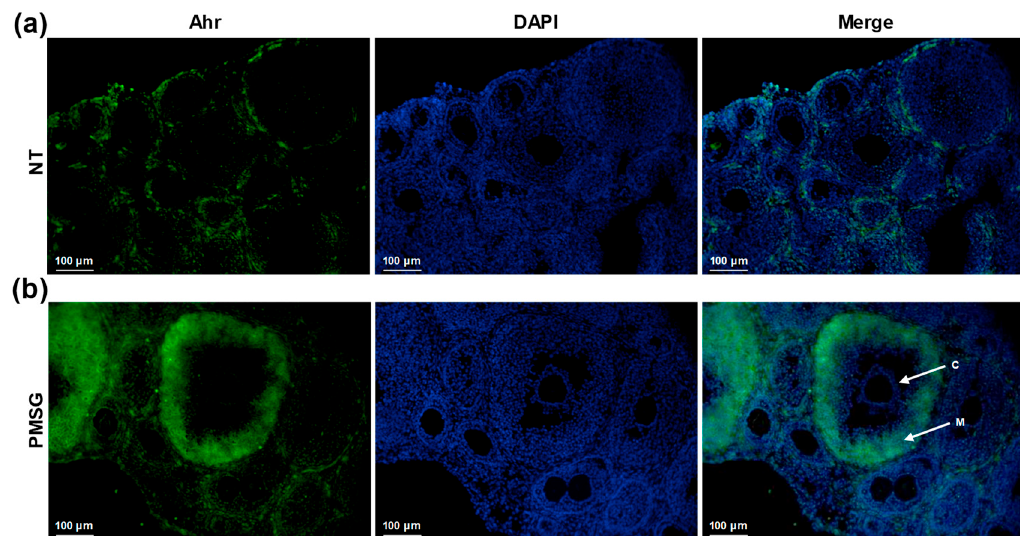
Figure 3. The effect of PMSG treatment on Ahr localization in ovary in vivo. Mice were injected with 5 IU of PMSG or vehicle (NT) and ovaries were isolated 48 h later. Representative images of immunofluorescence analysis of vehicle-treated ( a ) and PMSG-treated ( b ) ovaries from three independent experiments using Ahr-specific antibody (green). Nuclei were stained with DAPI (blue). Normal rabbit IgG as primary antibody was used for isotype control (Supplementary Figure S2). C—cumulus granulosa cells. M—mural granulosa cells. Scale bar, 100 μ m.